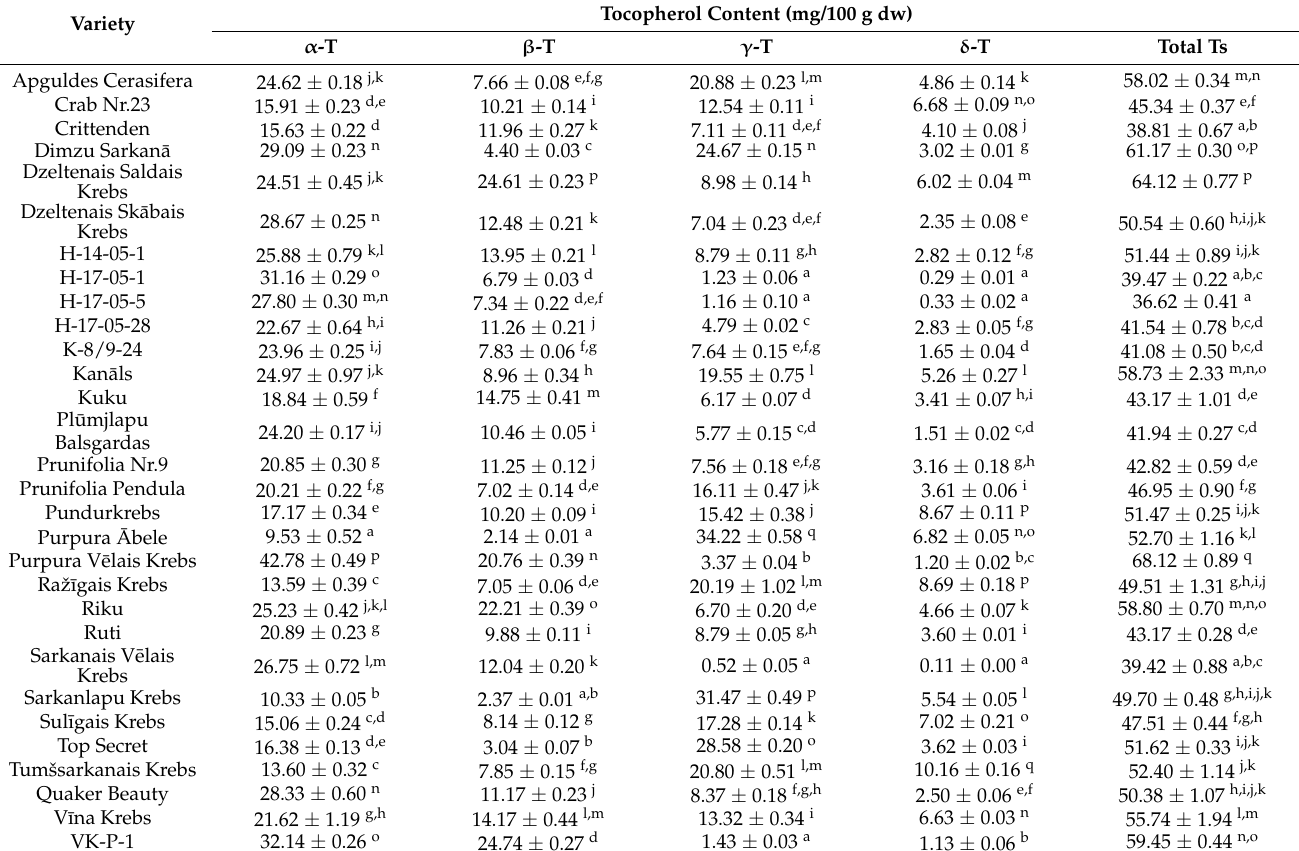
Table 2. Tocopherol homologue profile in different crab apple seeds ( Malus